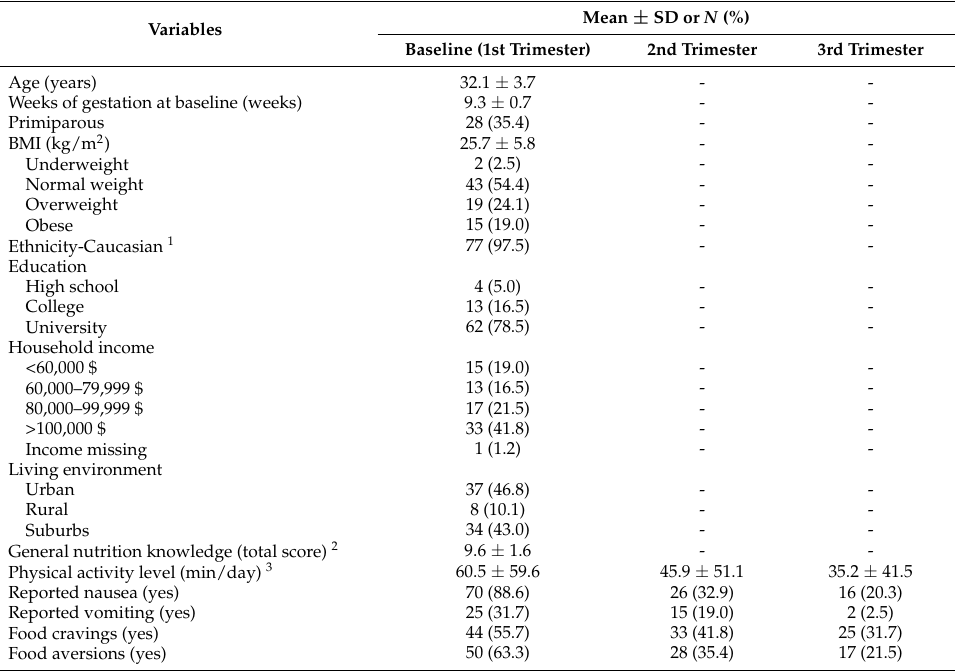
Table 1. Participants’ characteristics ( n =